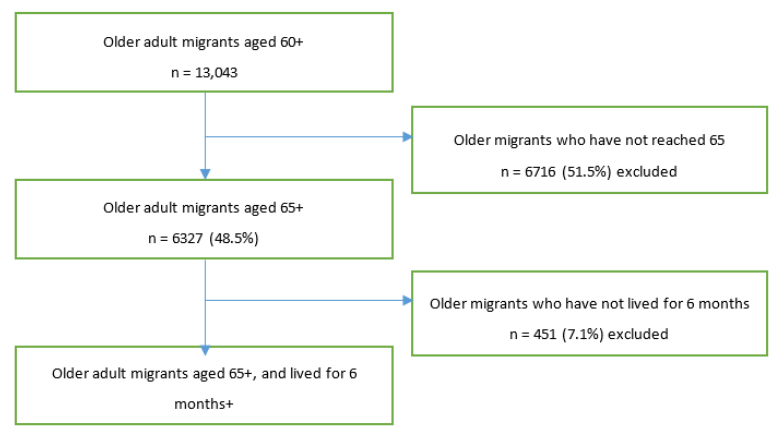
Figure 1. Sampling Figure 1. Sampling procedure.